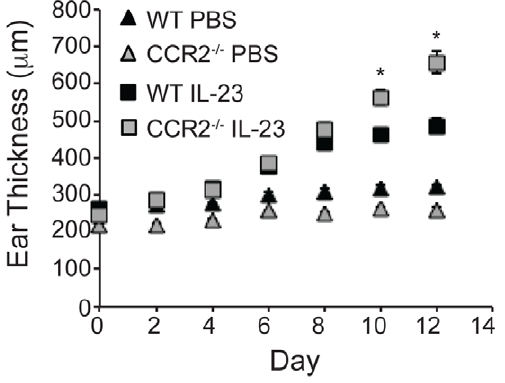
Figure 1. IL-23 injection induces increased inflammation in CCR2 2 / 2 mice compared to WT mice. Ears of CCR2 2 / 2 and WT mice were injected every other day with 20 m L PBS alone or containing 500 ng IL-23. Ear thickness was measured one day following each injection. Data are from at least 13 mice/group total in three separate experiments. *p , 0.01 versus all other